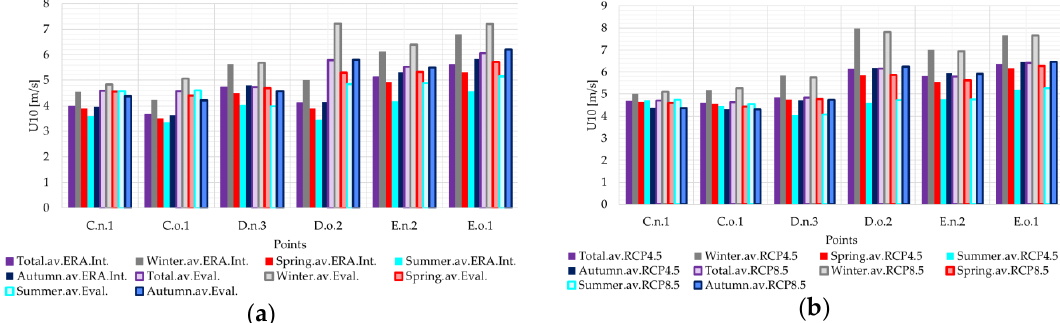
Figure 7. Seasonal wind speed averages at 10 m height compared with the total time averages for some representative points located in shallow water and deep water of Bulgaria and Romania coasts; ( a ) ERA.Int and Eval data, time interval 1980–2010; ( b ) RCP4.5 and RCP8.5 data, time interval 2021–2050.